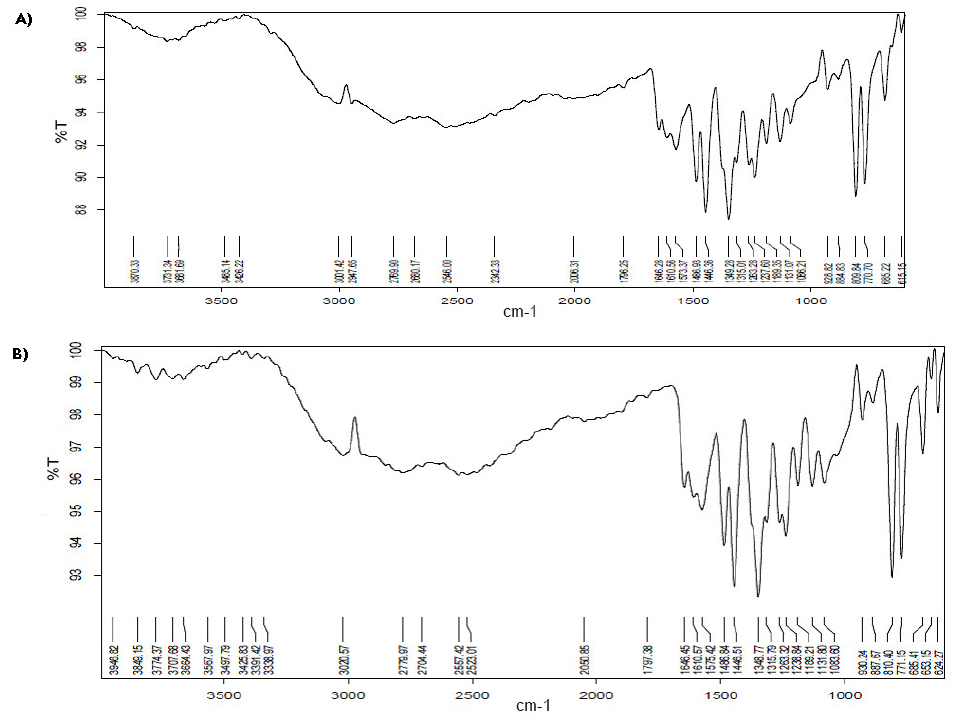
Fig. 3. Comparison of FTIR spectra of (A) mesalamine, (B) mesalamine-chitosan nanoparticles